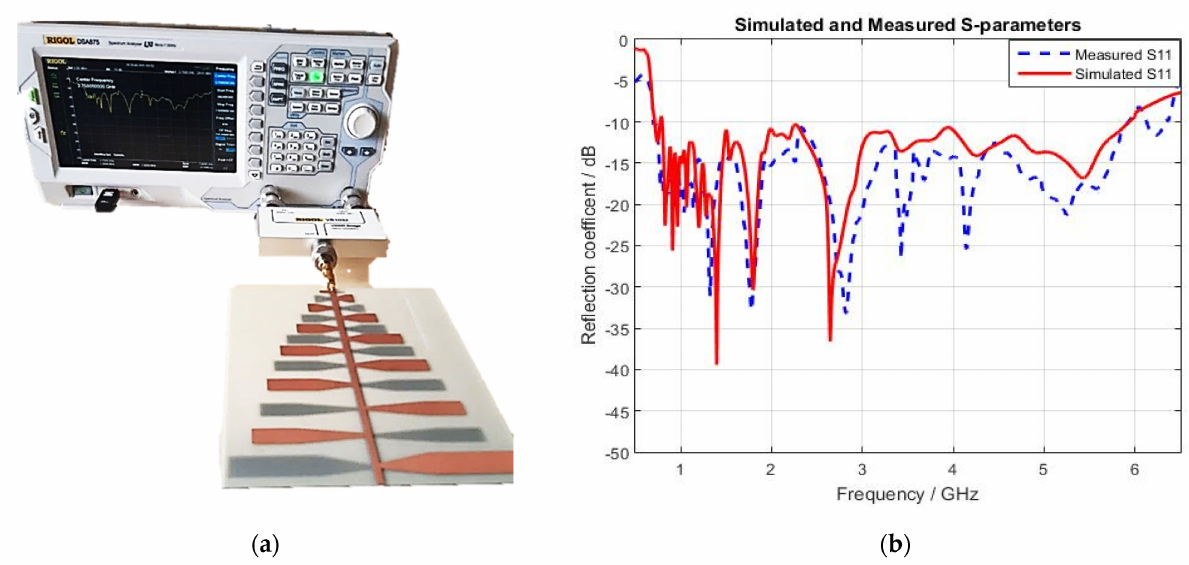
Figure 12. ( a ) The reflection coefficient measurement setup of the proposed structure; ( b ) simulated and measured return losses versus frequency.